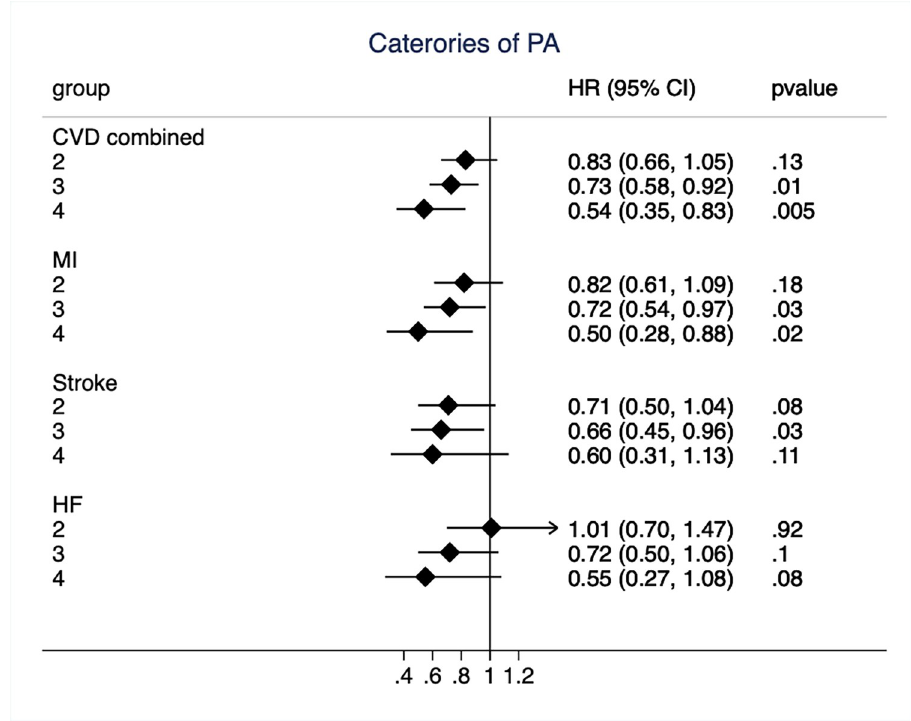
Fig 3. Hazard ratio (HR) and 95%CI for of physical activity (PA) when groups with PA-level 2 to 4 were compared to the reference PA-group one (sedentary) for the combined end-point of cardiovascular disease (CVD) and the three CVD-components separately in models adjusted for age only. MI, myocardial infarction; HF, heart failure.